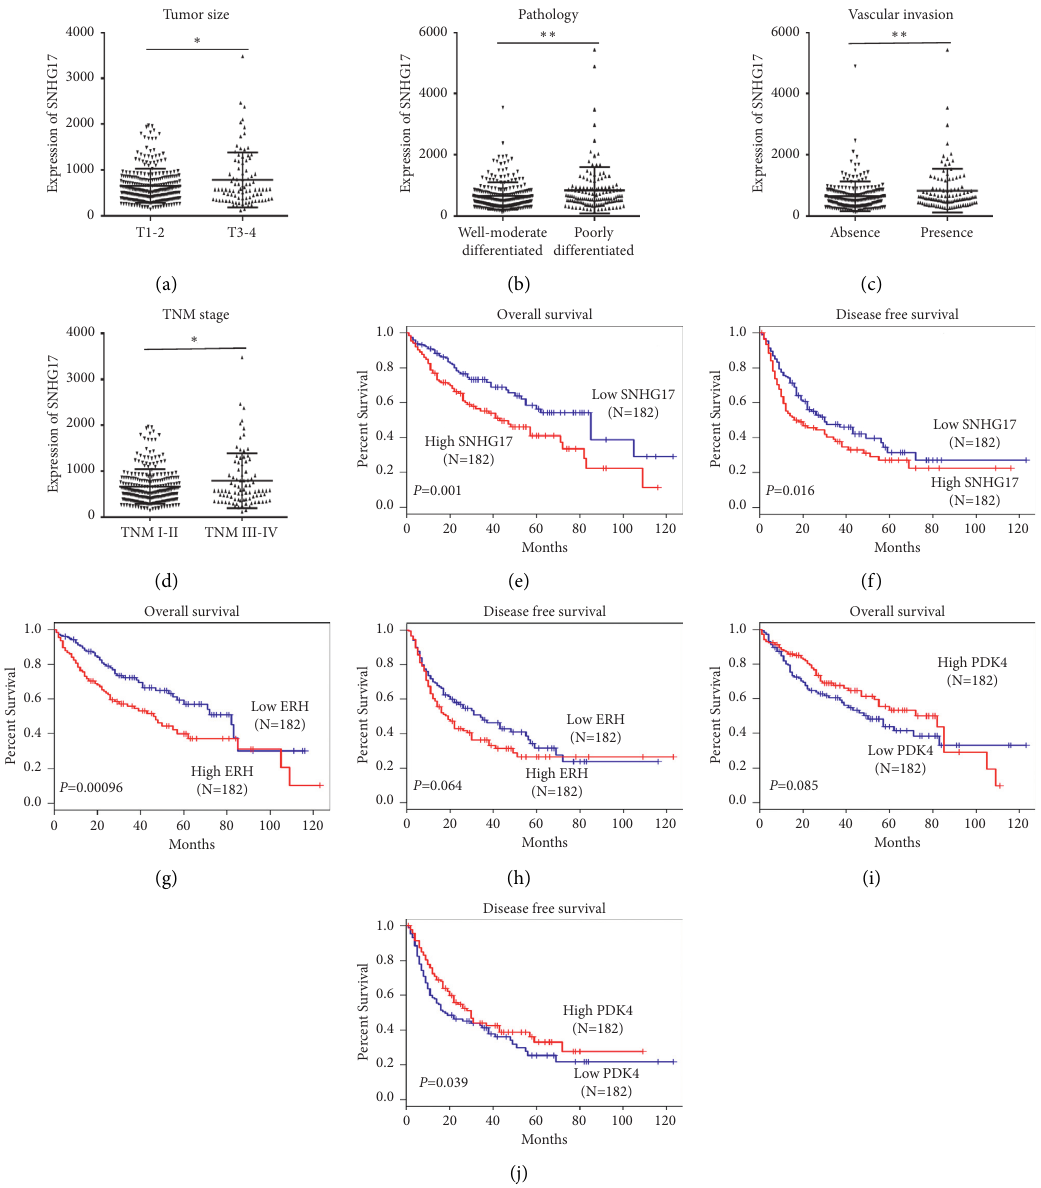
Figure 6: SNHG17 was correlated with poor prognosis of HCC. (a–d) Elevated SNHG17 expression was correlated with larger tumor size, poor differentiation, the presence of vascular invasion, and advanced TNM stage in HCC patients. (e-f) Kaplan–Meier curves for SNHG17 in HCC. (g-h) Kaplan–Meier curves for ERH in HCC. (i-j) Kaplan–Meier curves for PDK4 in HCC. ∗ P < 0 . 05 and ∗∗ P < 0 .